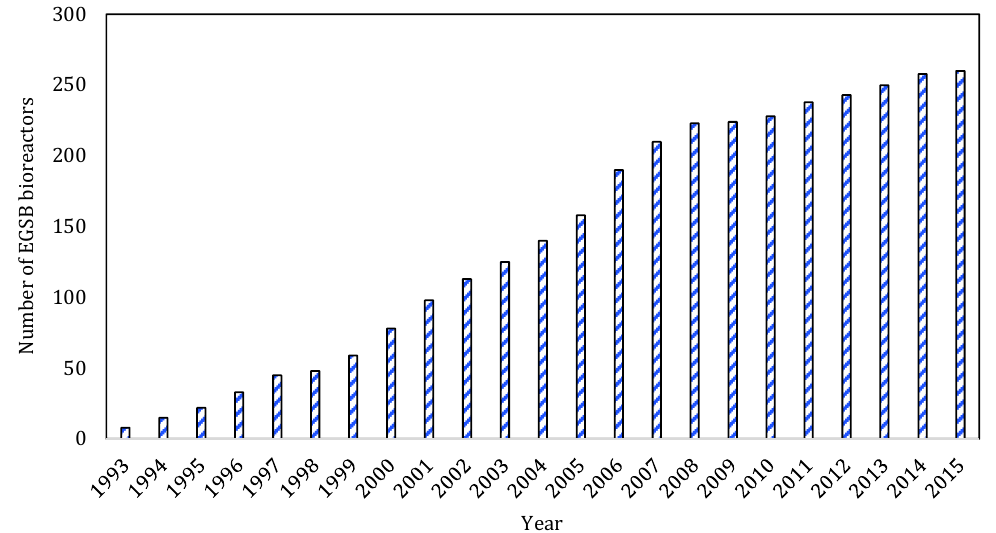
0 Fig. 5: Relative number of sales of Biobed EGSB bioreactors by Biothane-Veolia, period Year Fig. 5: Relative number of sales of Biobed EGSB bioreactors by Biothane‐Veolia, period 1993–2015.